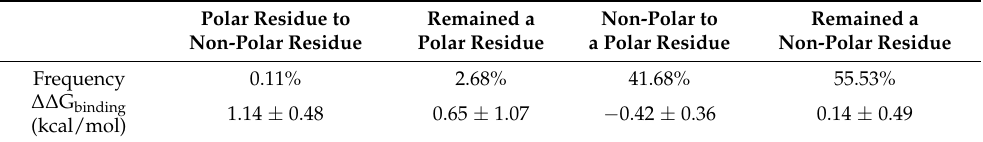
Table 3. ∆∆ G binding average values for four different sets of residues according to polarity change.